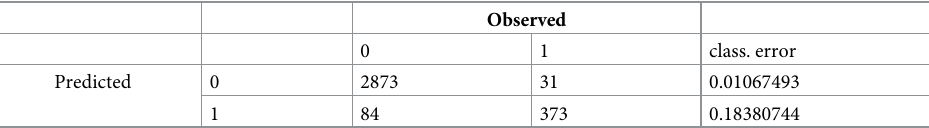
Table 5. RF confusion matrix–Model 1b.